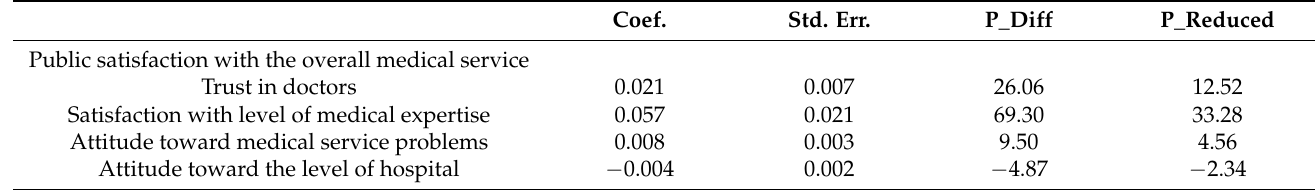
Table 4. KHB mediation analysis to determine contributions of mediators.